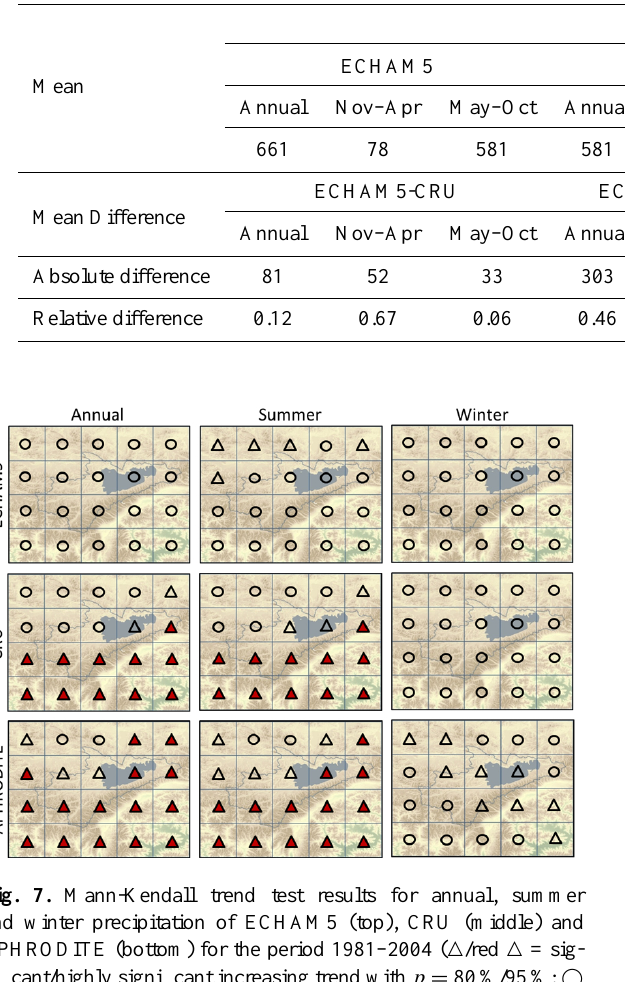
pattern by Leber et al. (1995). However, the resolution of 0.25 ◦ is still not able to capture the orographic effects of